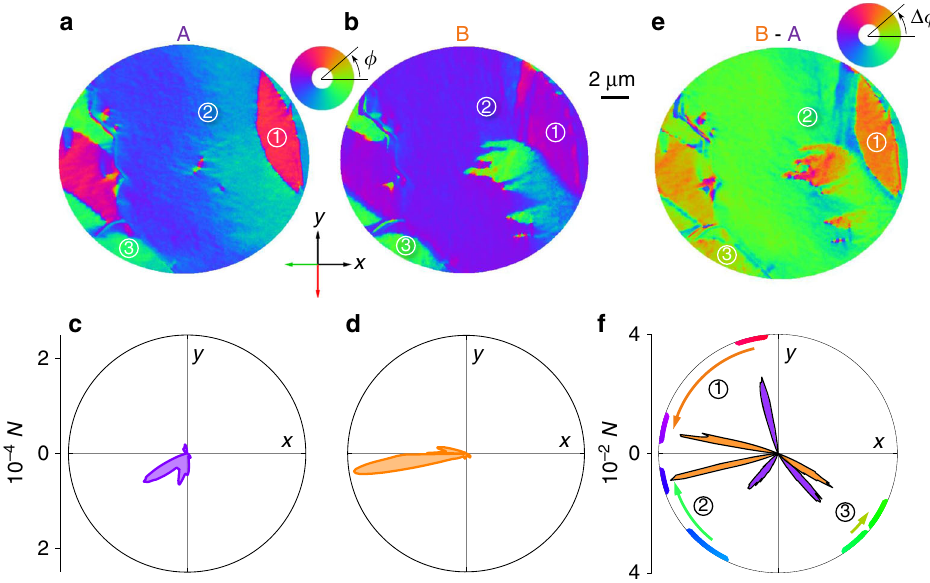
Fig. 5 Electrically induced rotations of magnetic domains in LSMO:PMN-PT. For remanent states a , c A and b , d B, we show the N pixels in our 20- μ m- diameter fi eld of view with in-plane magnetization direction ϕ on a , b XMCD-PEEM vector maps and c , d polar plots. Comparison of a , b yields e a map of changes in pixel magnetization direction Δ ϕ . f Polar plot describing 1.3- μ m-diameter regions [1 – 3 in a , b , e ] at electrically remanent states A (purple lobes) and B (orange lobes), with pixel colours and angular changes marked on the periphery. Straight green and red arrows denote the in-plane projections of the grazing-incidence X-ray beam that were used to obtain the vector maps in a , b . All data were obtained for sample A following macroscopic magnetoelectric measurements and subsequent thermal demagnetization. All data were obtained at room temperature. Source data are provided as a Source Data fi